Question: Generate an informative caption for the figure above.
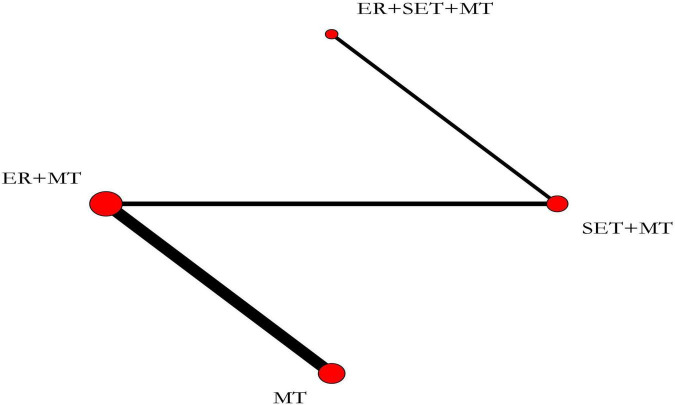
Answer: Network plot for amputation incidence. Node size is proportional to sample size, and line thickness is proportional to the number of studies.